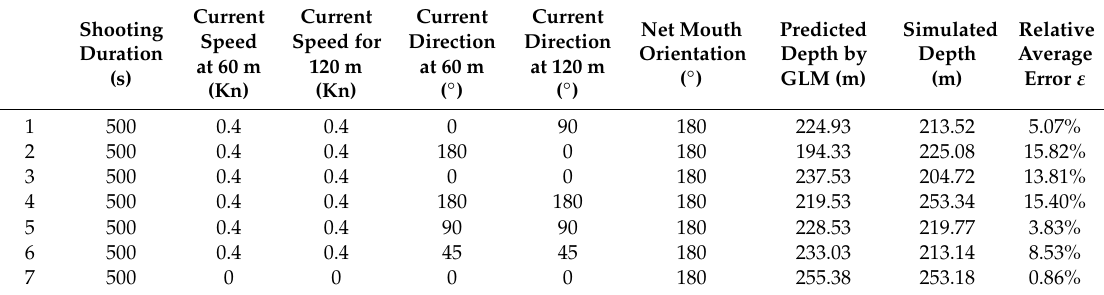
Table 3. A comparison between the standardized maximum depths of the middle part of the lead line from the field measurement and those from simulation under seven cases. Relative average error ε is defined as the absolute value of difference between the model-predicted and simulation-based depth divided by model-predicted depth. GLM, generalized linear model.